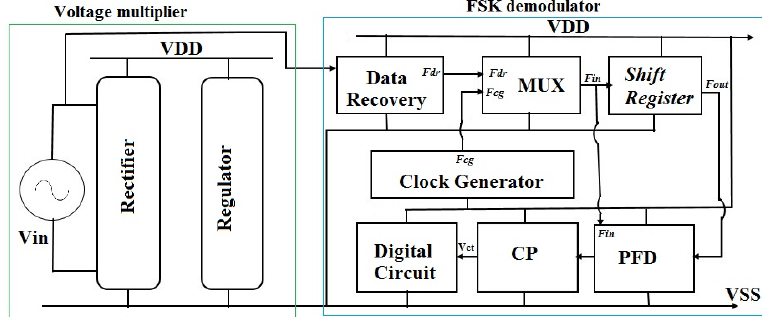
Figure 2. Shift register in the analog front-end of a RFID tag. Reproduced with permission from [8], IEEE,